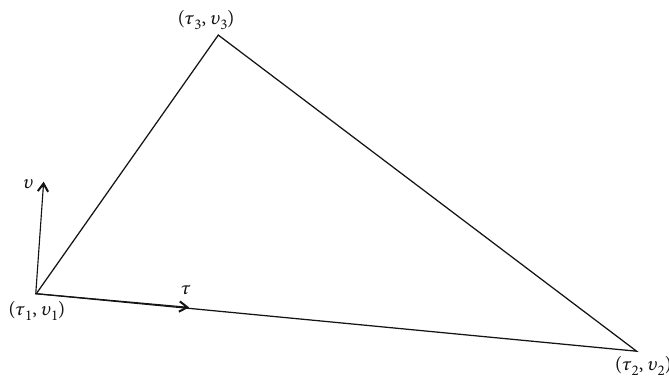
Figure 12: Local coordinate of a triangular facet for calculation of direct RMS error. intersections between the line and the parabolic working surface